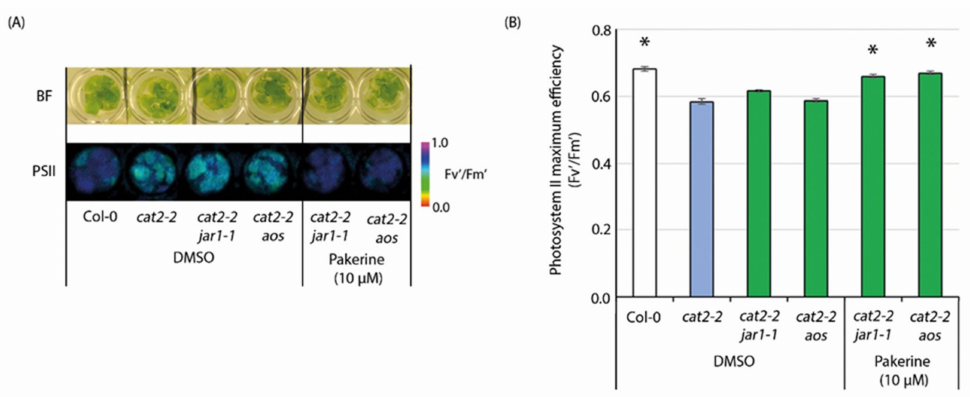
Figure 9. Jasmonic acid (JA) signaling is not required for pakerine function. ( A ) Representative bright-field (BF) and color-coded F v ’ / F m ’ (PSII) images of cat2-2 jar1-1 and cat2-2 aos double mutants treated with 10 µ M pakerine and exposed to photorespiratory stress together with mock-treated controls. ( B ) Quantitative F v ’ / F m ’ data from plants treated as in ( A ). Data points represent means of eight individual measurements ± SE. Asterisks indicate significant di ff erences according to one-way ANOVA with LSD post hoc test ( p <